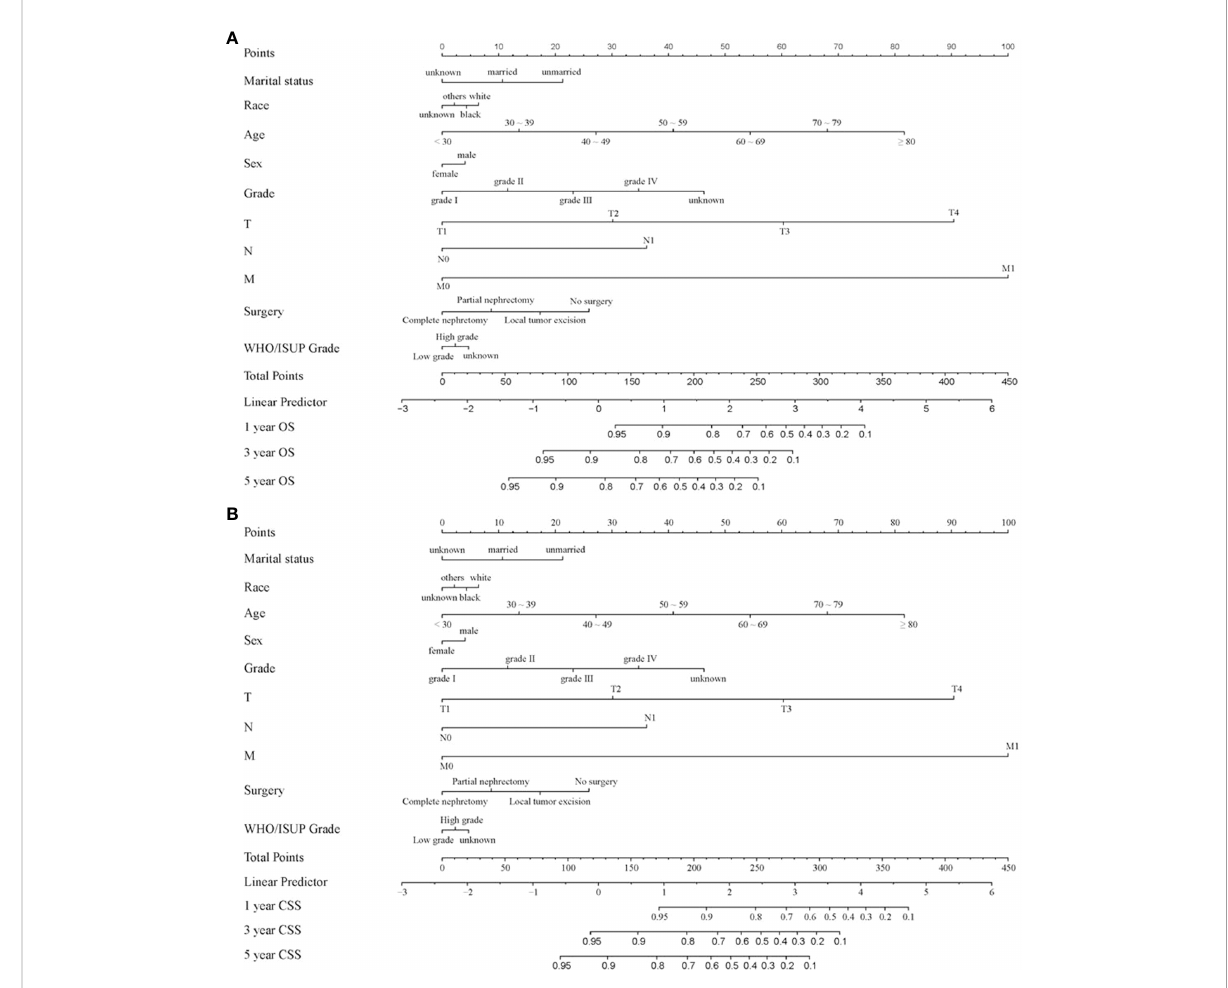
FIGURE 3 Nomogram for forecasting OS and CSS in CCRCC patients. (A) Nomogram forecasting 1-year, 3-year, and 5-year OS in CCRCC patients; (B) Nomogram forecasting 1-year, 3-year, and 5-year CSS in CCRCC